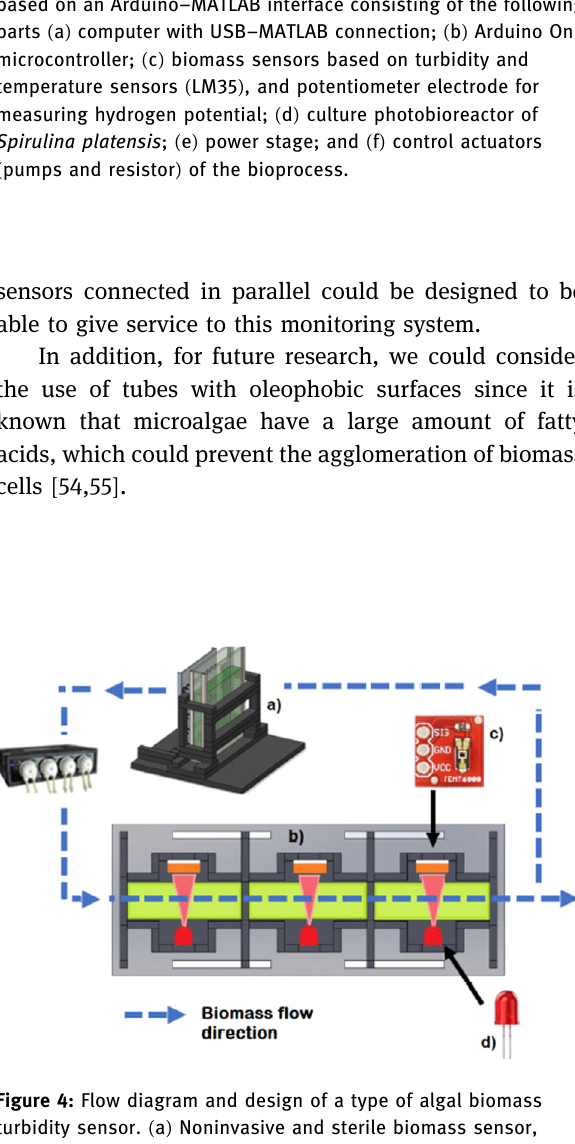
Figure 5: In black trace, the experimentally obtained glucose is shown. The black solid line shows the calculated analog substrate signal with the high - gain robust observer, i.e., x ˆ 2 . The blue cut line represents simulation results